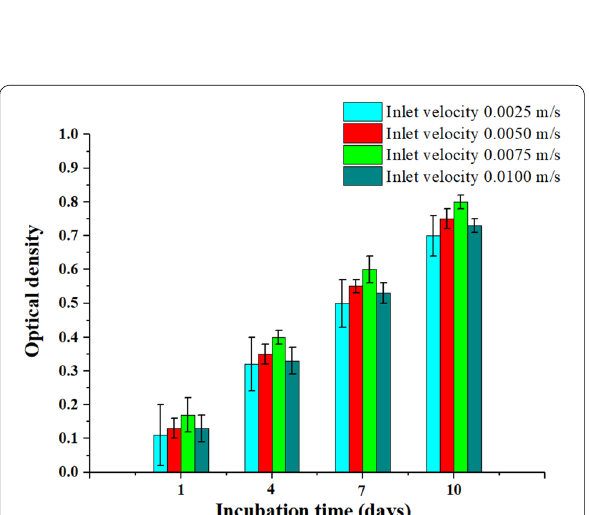
Figure 21 Optical density indicating the cell proliferation performance (the five identical scaffold samples were seeded with BMSCs, and the pore diameter is 434